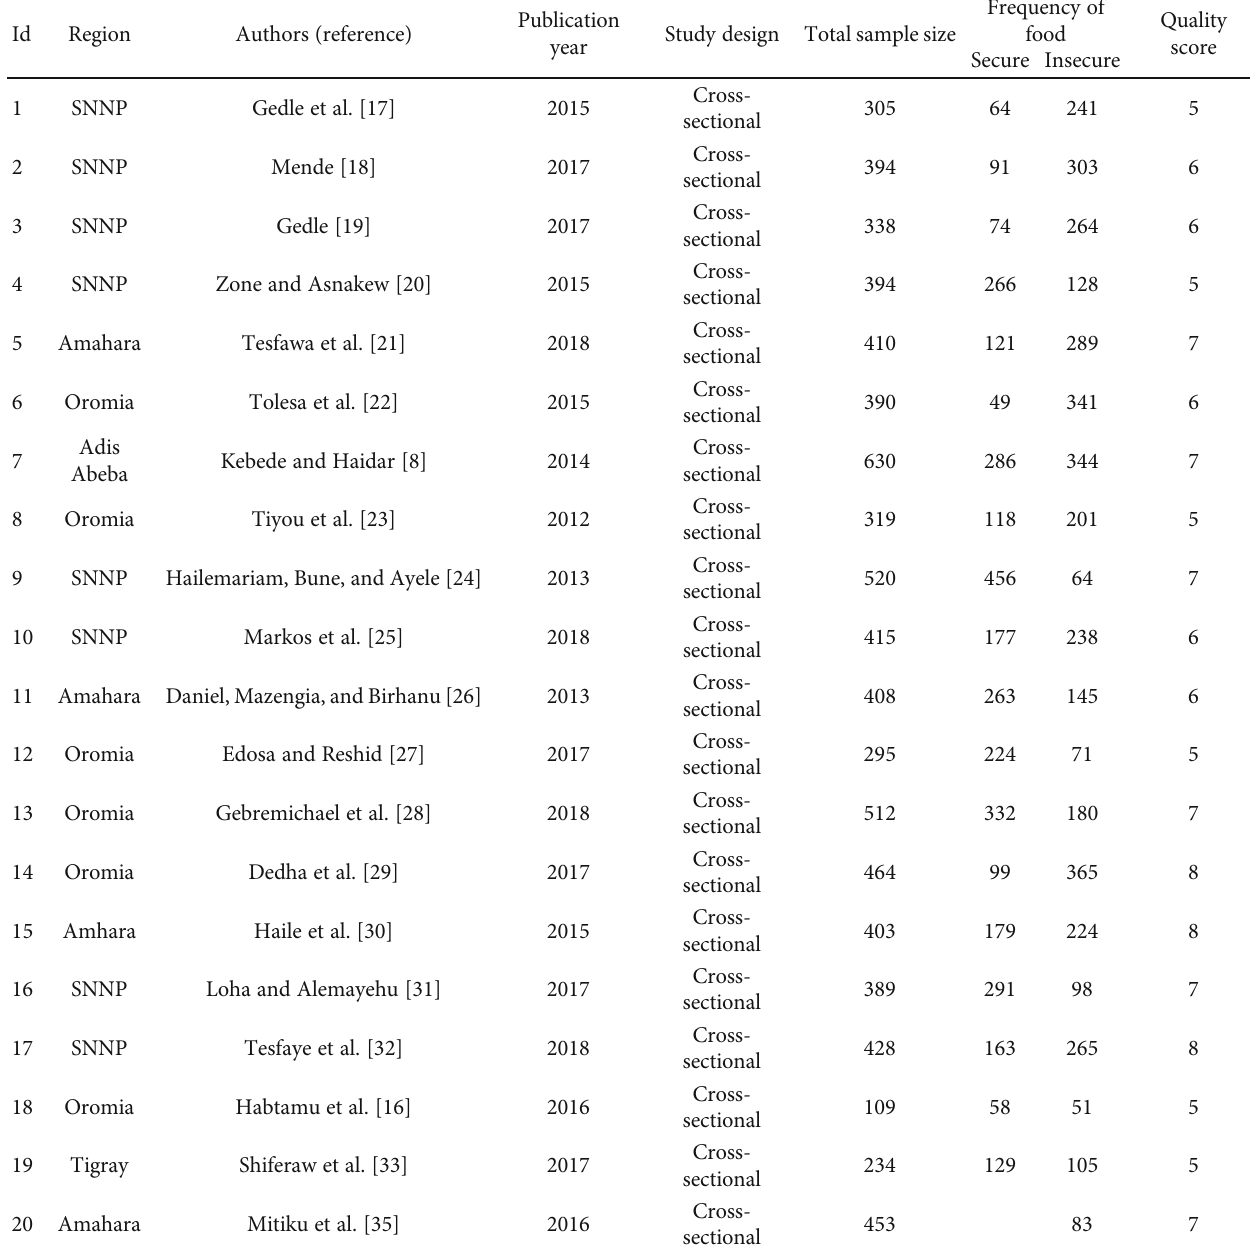
SNNP: Southern Nation Nationality